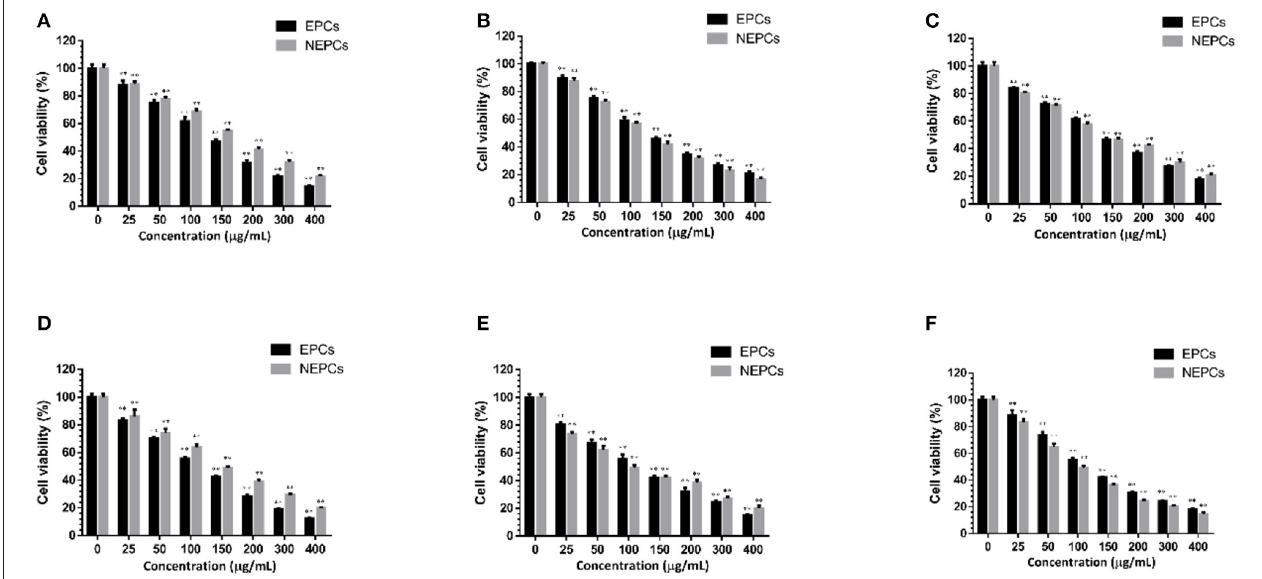
FIGURE 6 | Suppressive effects of the EPCs and NEPCs from L. japonica (A) , P. tenera (B) and U. lactuca (C) on HCT116 cells for 48 hours; Suppressive effects of the EPCs and NEPCs from L. japonica (D) , P. tenera (E) and U. lactuca (F) on HCT116 cells for 72 hours. Results were presented as mean ± SD ( n = 6). ** p < 0.01 indicate statistically differences from untreated